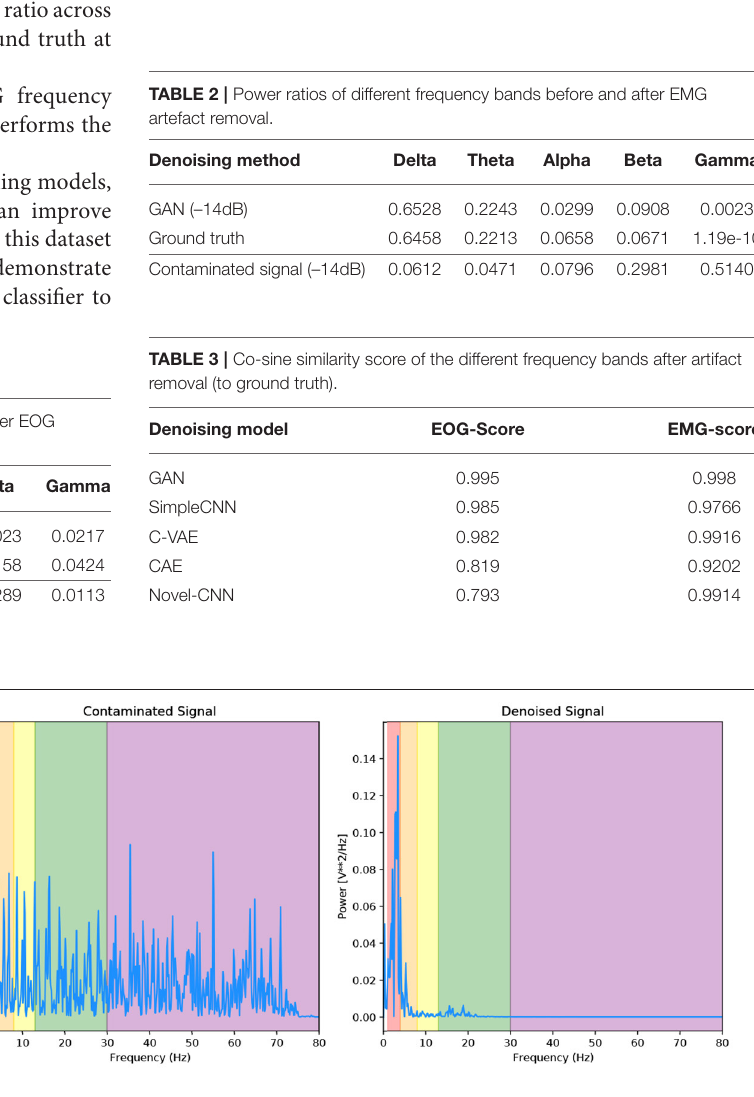
FIGURE 9 | PSD of the EEG-EMG signals shown in Figure 5 (right) with corresponding EEG bands.